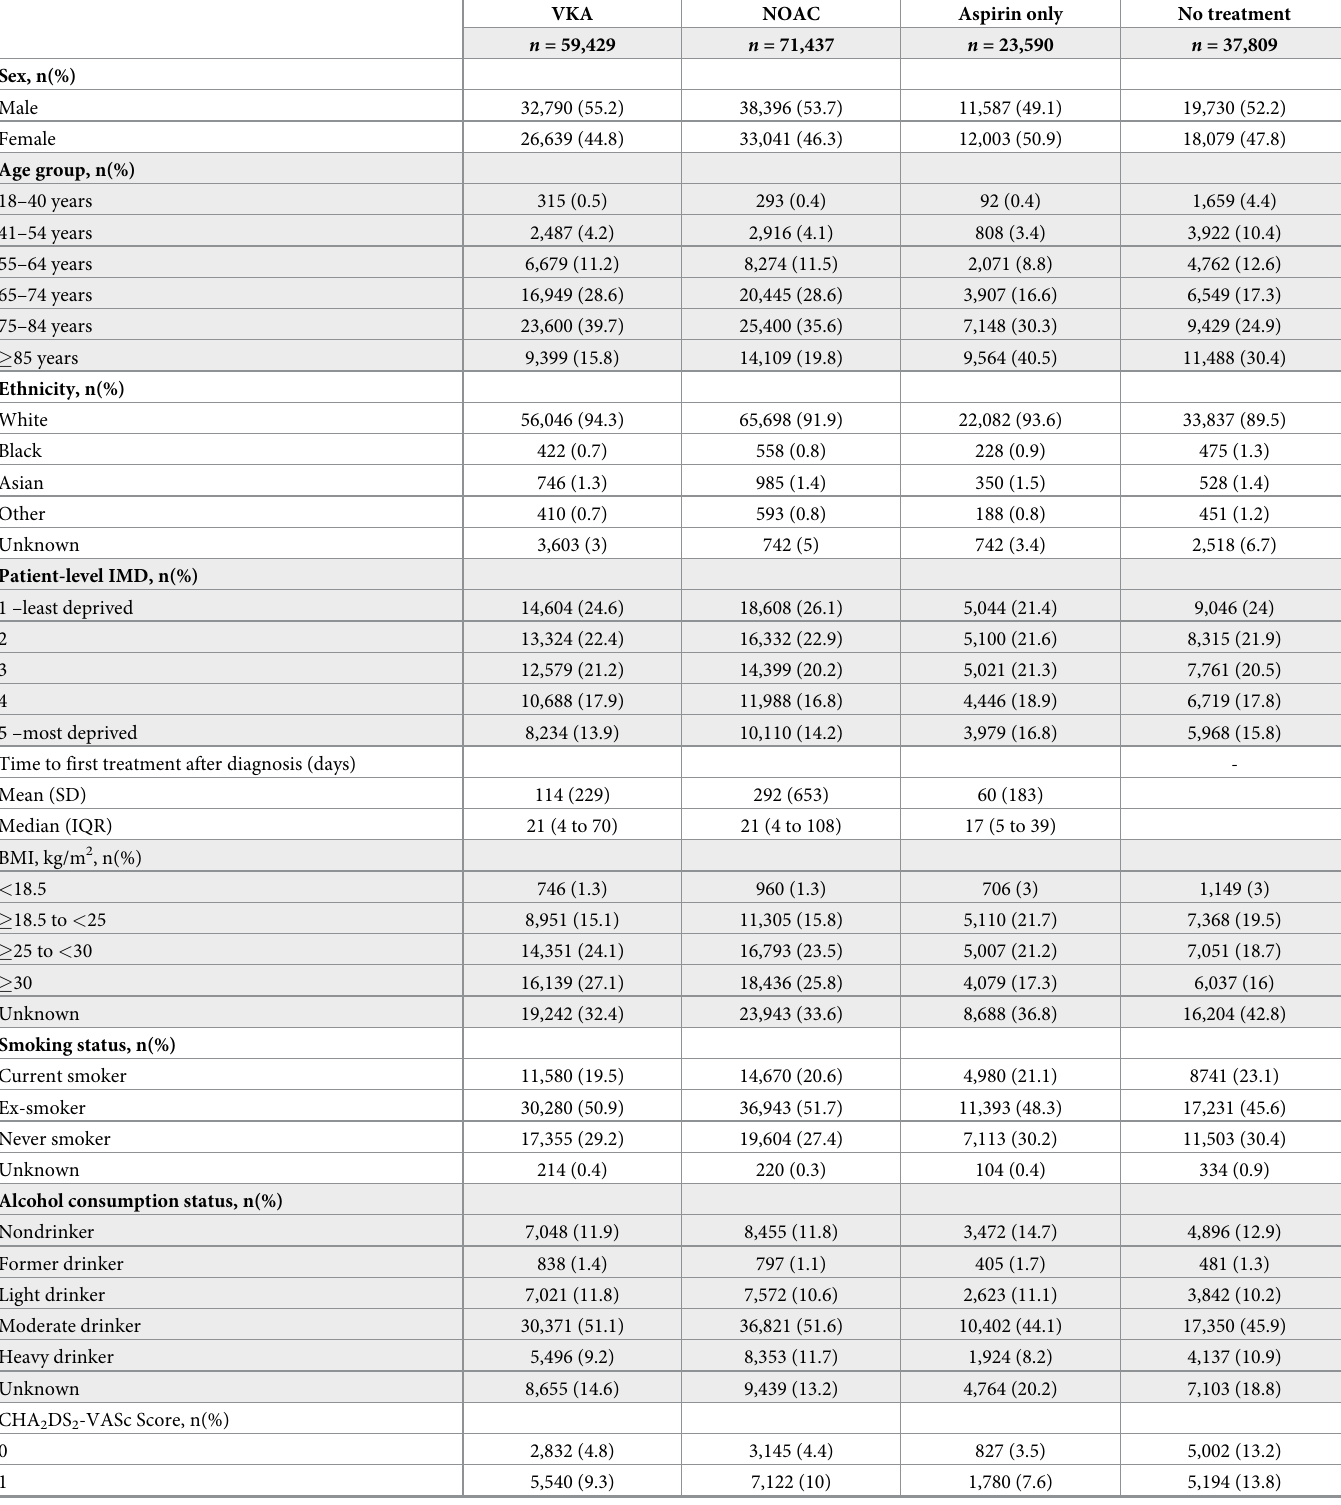
Table 2. Patients’ characteristics by first continuous treatment episode of